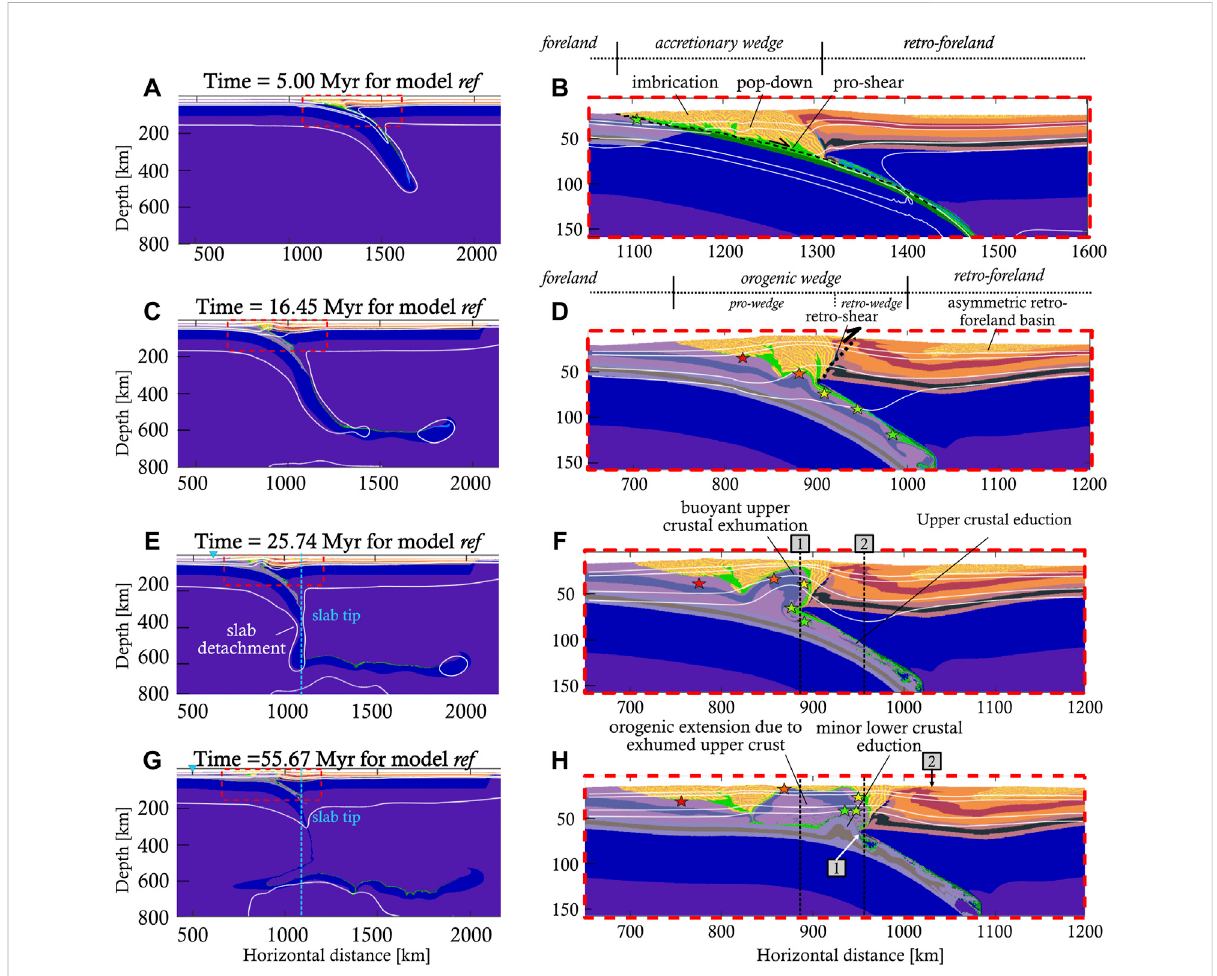
FIGURE 3 Four snapshots of the reference model at key stages of its development, showing rock composition and isotherms (100 C, 150 C, 350 C, 450 and 1300 C). In addition, PTt marker positions are shown in the same fashion as in Figure 2 (A,B) During the initial stage, imbricate thrusts develop, as well as pop-down structures. Prescribed oceanic subduction has just been switched off. A single-vergent orogen has developed. (C,D) After continental collision followed by a stage of trench shift towards the foreland, the orogen is now double-vergent. The retroshear and asymmetric retro-foreland basin are indicated. The fi rst signs of upper crustal eduction are visible. (E,F) The oceanic slab has detached, resulting in slab rebound and unbending. The upper crust has almost fully educted from the subduction channel and is now exhuming, pushing the overlying material up and to the sides. [1] and [2] denote the plate boundary and the retro-wedge deformation front, respectively. The trench position is indicated with a blue triangle (G,H) The model has reached a quasi-steady state. The buoyant upper continental crust forms the core of the orogen. Some lower crust has started to exhume along the retroshear as well, but it is too dense to exhume further. No post-detachment slab rollback takes place, but the overriding plate has retreated by ~60 km at depth [1] and ~70 km at the surface [2]